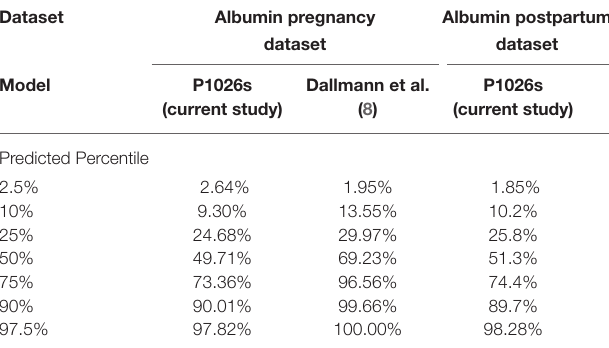
TABLE 2 | Percent of observed albumin concentrations in pregnant and postpartum women living with HIV that fall below model-predicted quantiles (associated with specified